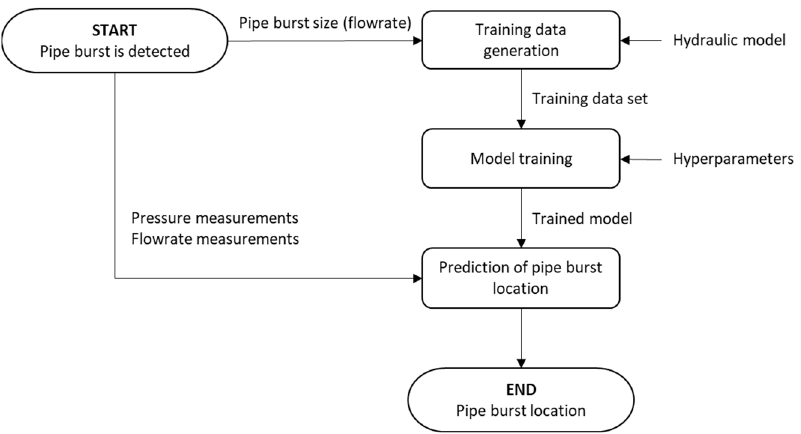
Figure 1. Flowchart of proposed methodology for pipe burst location using neural networks.